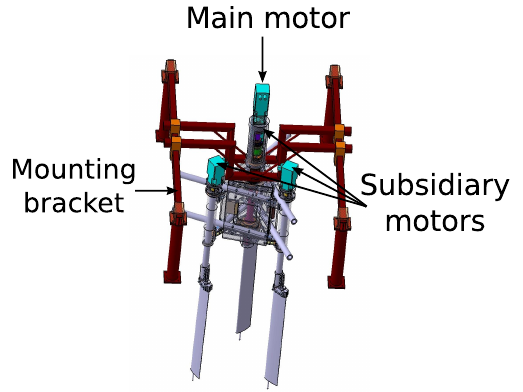
Figure 1. Computer Assisted Design (CAD) model of the SHIVA